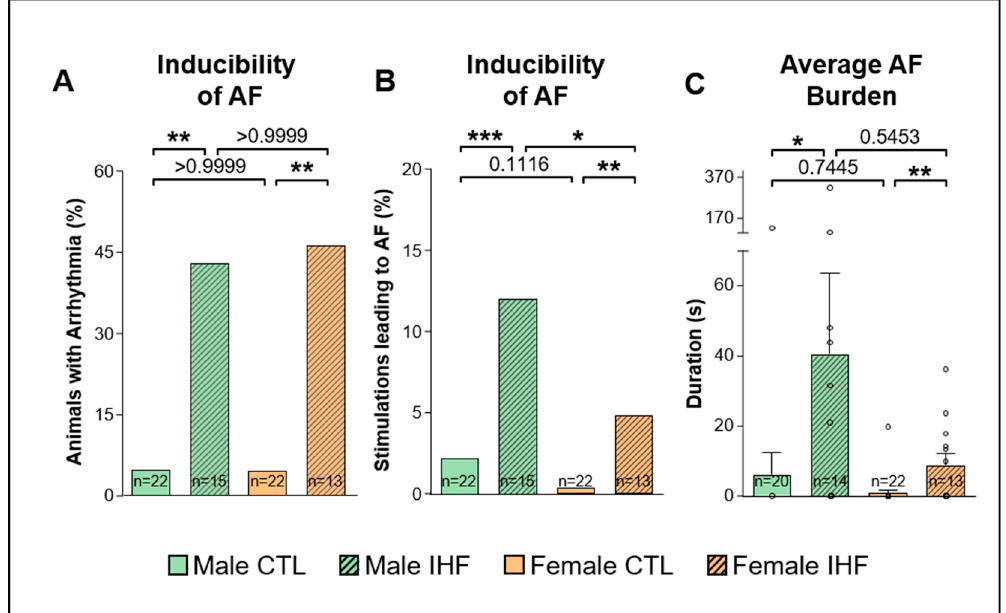
Figure 4. Inducibility of Atrial Fibrillation (AF) ( A ), Percentage of pigs with AF episodes longer than 10 s. ( B ), Percentage of burst stimulations leading to AF episodes longer than l0 s. ( C ), Average AF burden. CTL , control animals without ischemic heart failure; IHF , animals with ischemic heart failure. Bar graphs represent Mean + SEM, grey circles represent data of individual pigs. Fisher’s Exact Test ( A , B ) and Mann-Whitney-U Test ( C ). * p < 0.05; ** p < 0.01; *** p < 0.001.